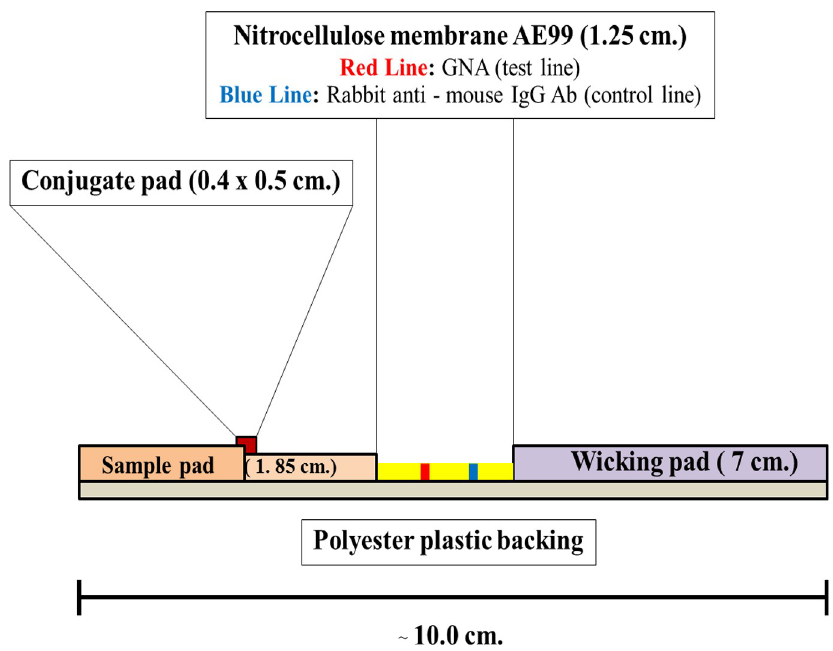
Fig 3. The side view cartoon formats of the components and construction of GNA- MAb 4D1 sandwich ICT strip.